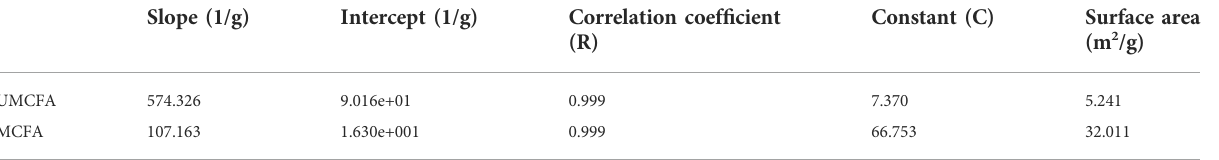
TABLE 2 BET comparison analysis of before and after modi fi cation of